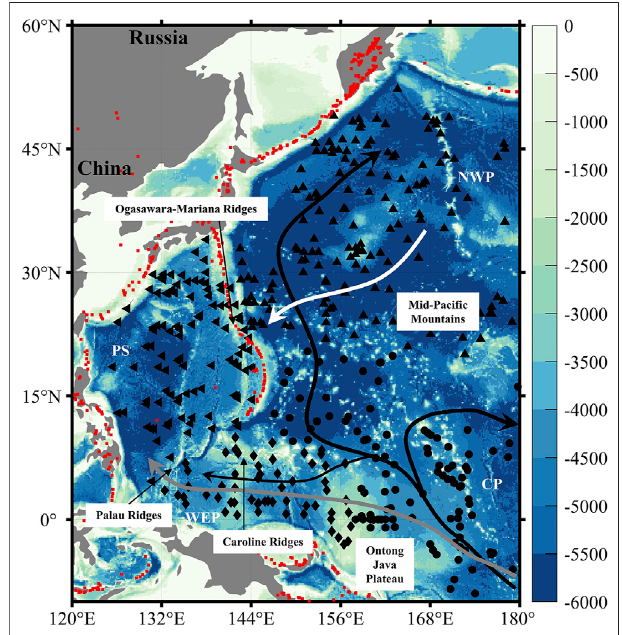
FIGURE1| Mapofthestudyregionwithblackmarkersrepresenting the locations of sediment cores (triangle — the Northwest Paci fi c; left triangle — the Philippine Sea; diamond — the Western Equatorial Paci fi c; circle — the Central Paci fi c) (see Supplementary Table S1 ). White, gray, and black arrows show the pathway of the major deep thermohaline currents (e.g., the North Paci fi c Deep Water (NPDW), the Upper Circumpolar Deep Water (UCDW), and the Lower Circumpolar Deep Water (LCDW)) in the Paci fi c Ocean (Johnson and Toole, 1993; Kawabe et al., 2003; Fiedler and Talley, 2006; Kawabe and Fujio, 2010). Red rhombus represents major volcanoes and hydrothermal vents in the Paci fi c Ocean (Beaulieu, 2010; Venzke,